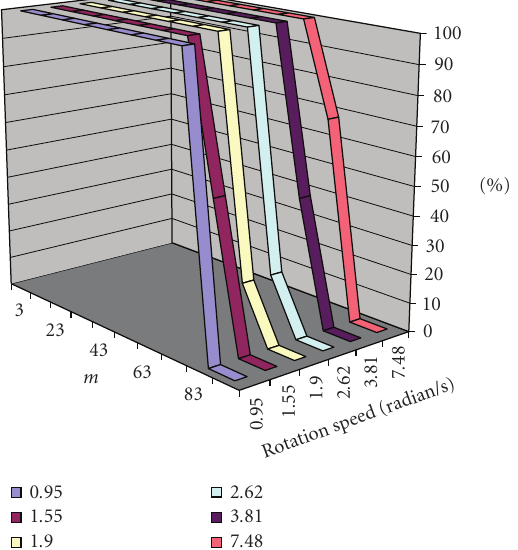
Figure 13: Successful recognition percentage as function of time window ( m ) and speed of movement for t settle = 900 milliseconds.